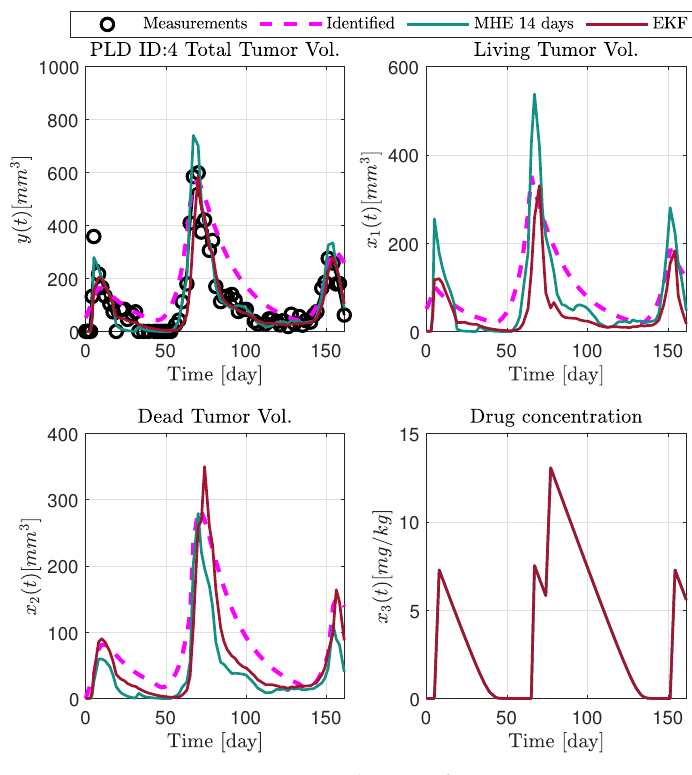
Figure 13. Estimated states of PLD4 mouse.